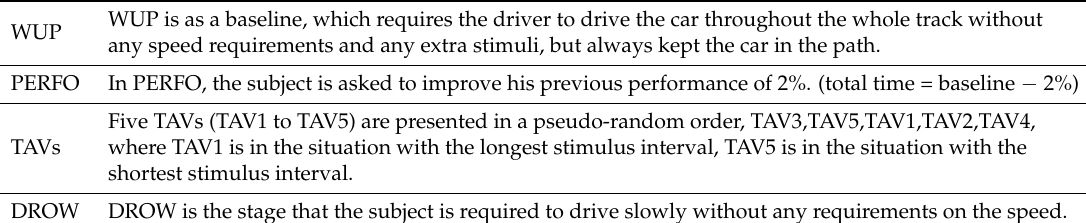
Table 1. Description of different